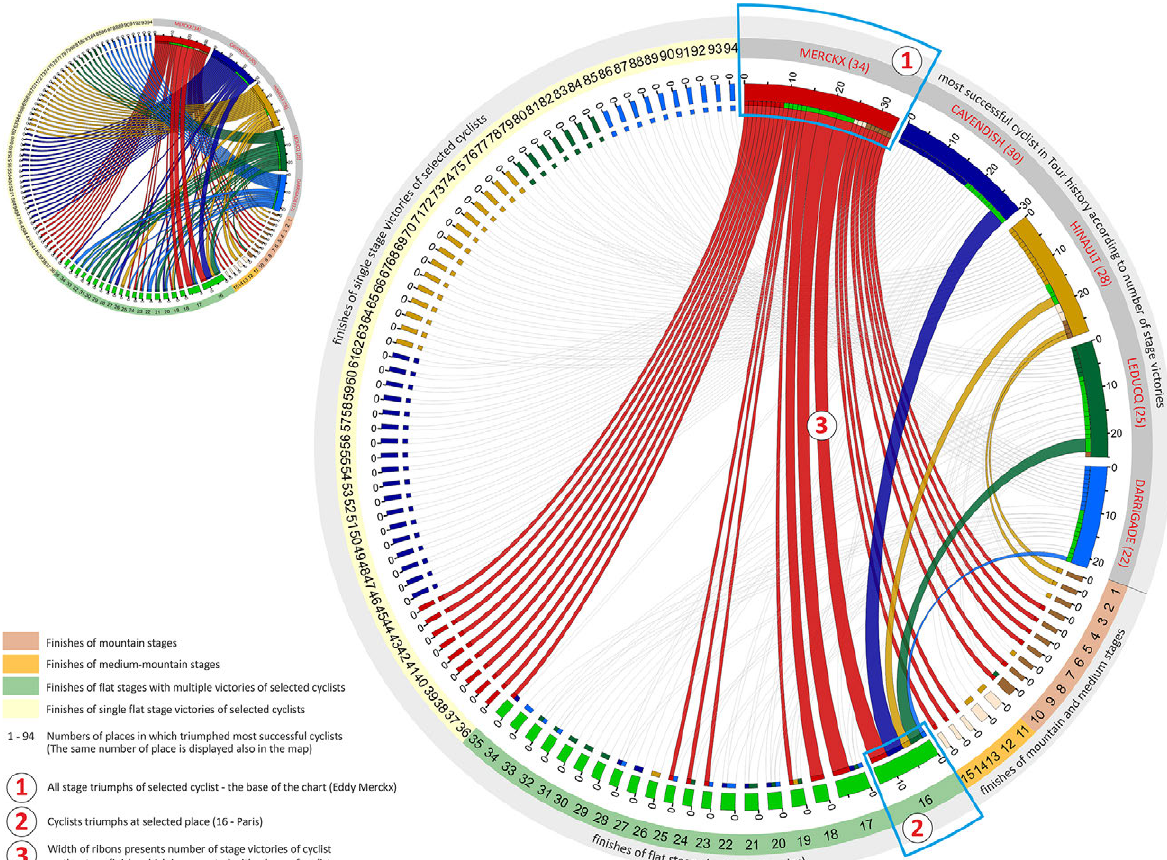
Fig. 3. Interpretation of the chord diagram (The original diagram is visually adjusted so that readers can see the main elements